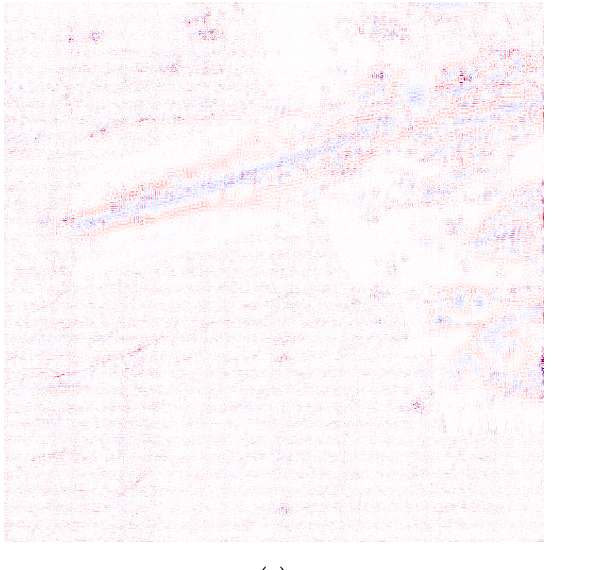
Figure 5. Seabed topography in area 0_2. ( a ) The original image; ( b ) Low-resolution input image; ( c ) Sparse coding super-resolution (ScSR: the proposed method); ( d ) Bicubic interpolation.